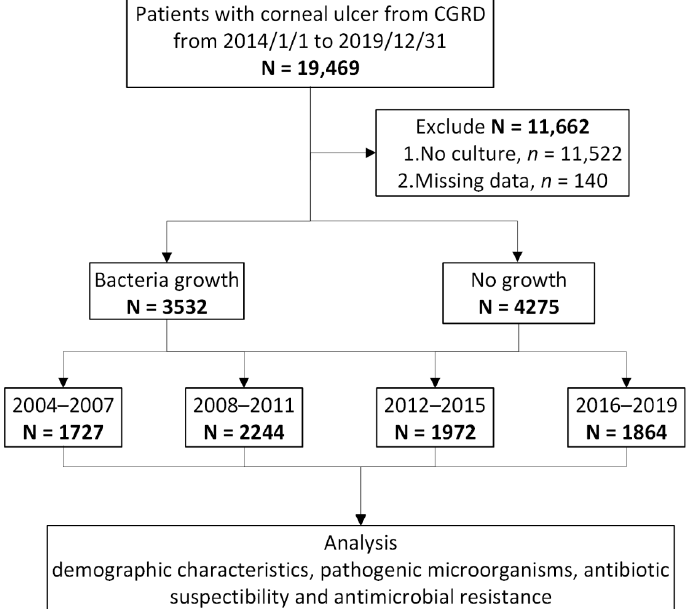
Figure 1. Flowchart of study population selection. CGRD, Chang Gung Research Database.